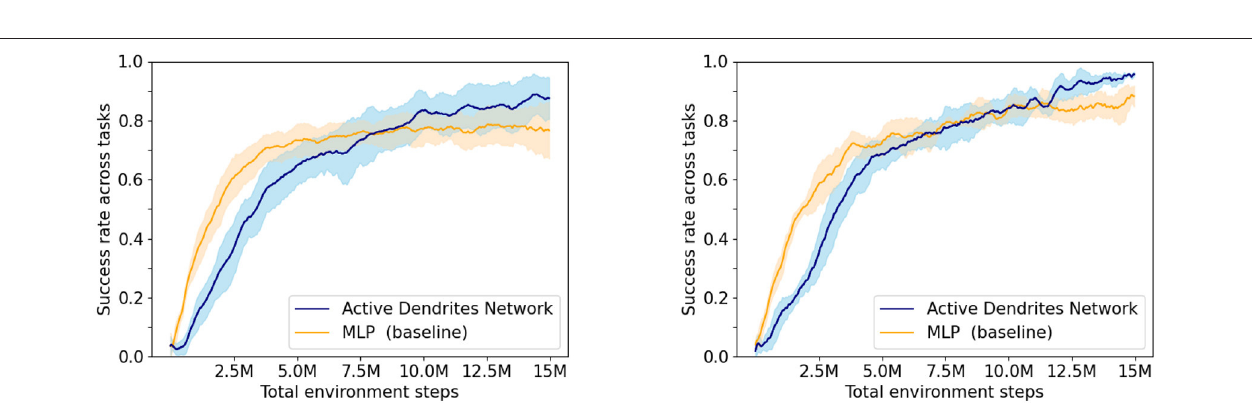
FIGURE 4 | An overview of the network structure used in our multi-task RL experiments. A k WTA activation is applied to both hidden layers. The context vector is the task ID. The dendritic segments in the second hidden layer receive this context vector as input.